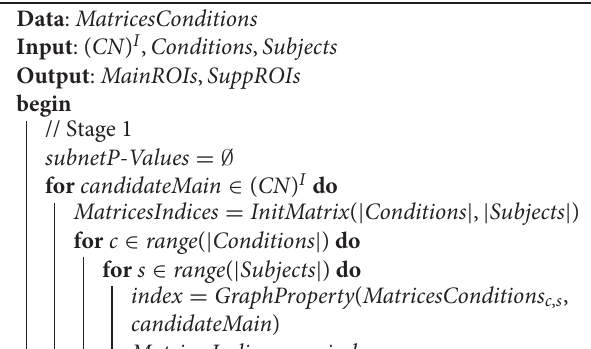
Algorithm 1: Main cognitive network